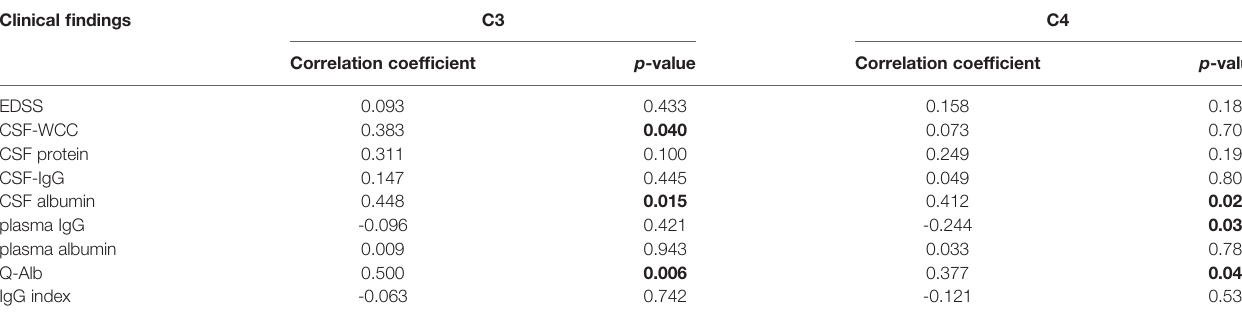
TABLE 3 | Correlations between plasma C3, C4, and EDSS, immunological fi ndings of NMOSD patients. Clinical fi ndings